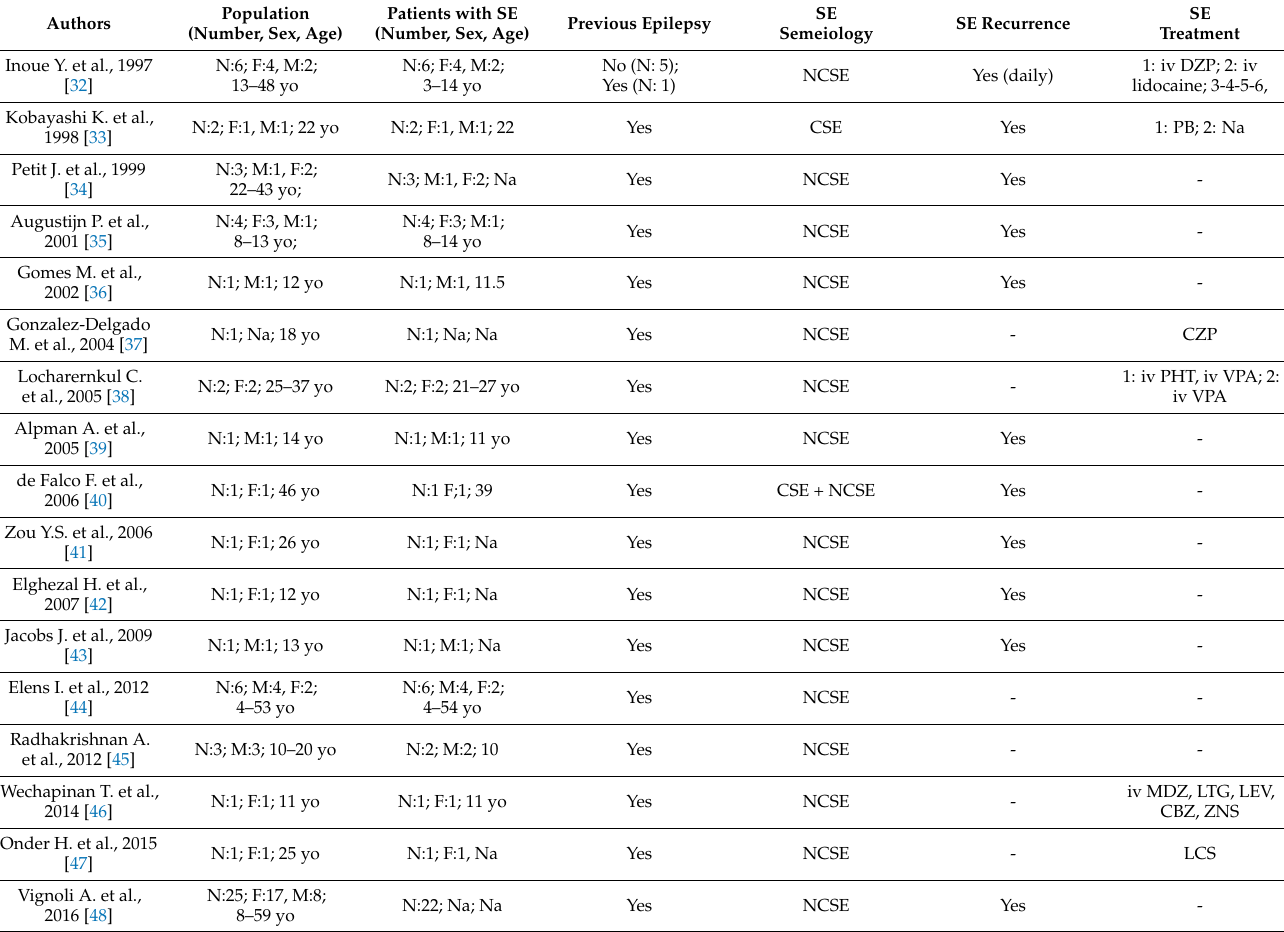
Table 4. Status Epilepticus in Ring 20